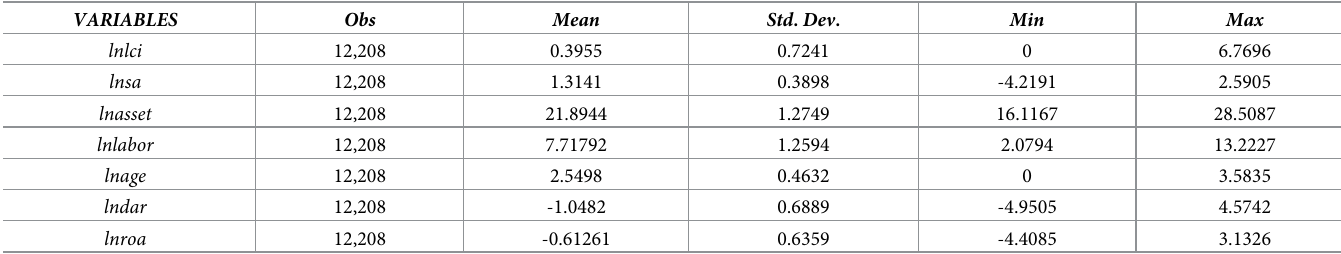
Table 1. Descriptive statistics of main